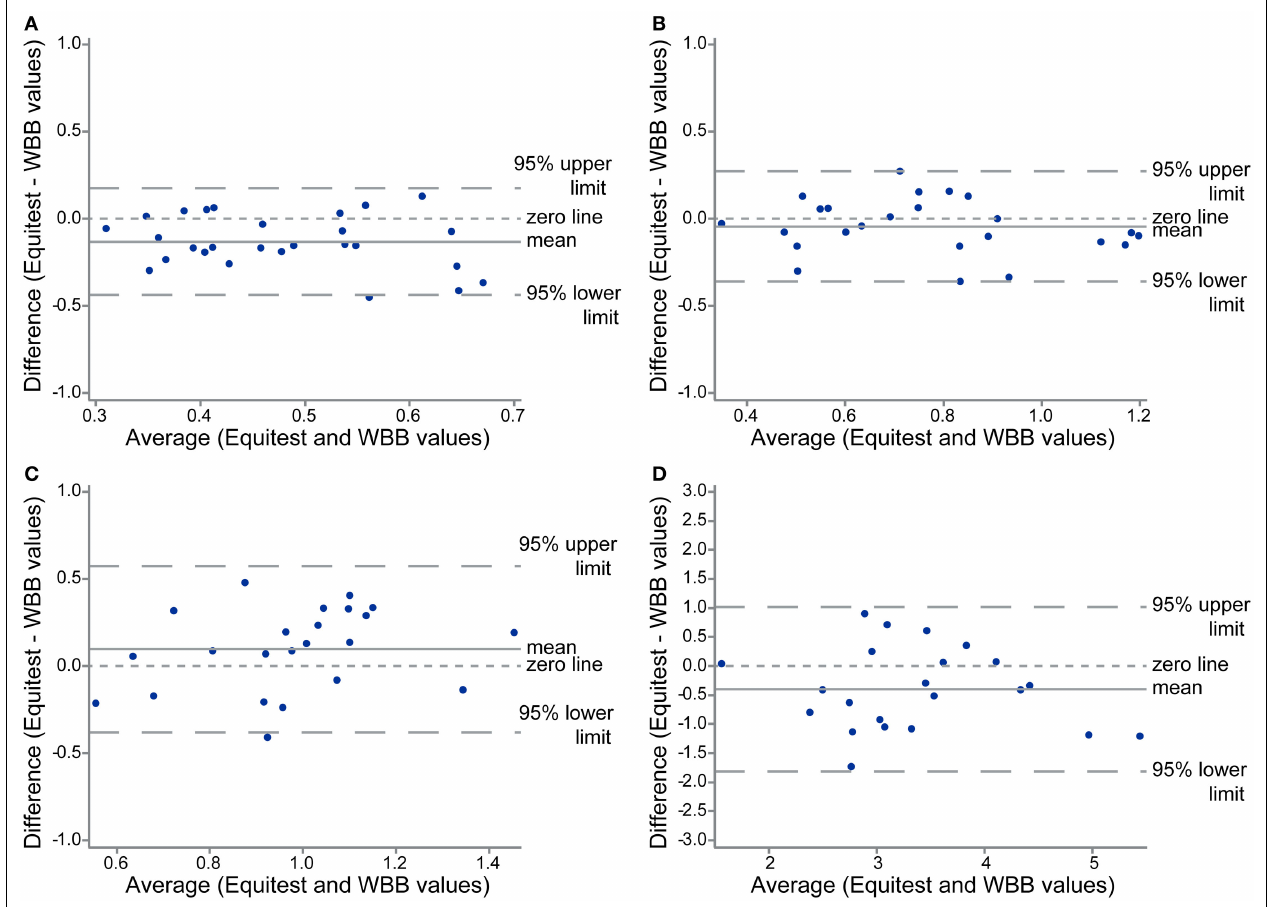
FIGURE 4 | Bland and Altman plots of the XY velocity for the four conditions: eyes open on platform (A), eyes closed on platform (B), eyes open on the foam (C), and eyes closed on the foam (D), showing agreement between the two set of measures: with the Equitest platform and the WBB .